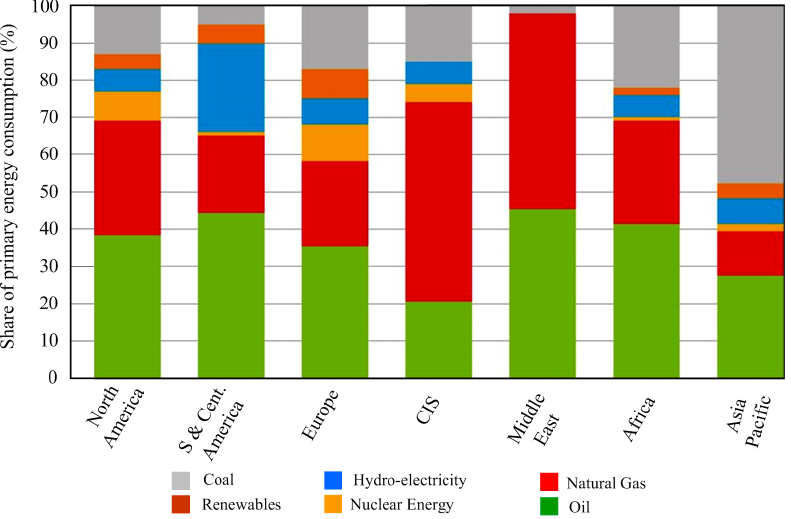
Figure 4. Region-wise primary energy consumption by fuel around the globe